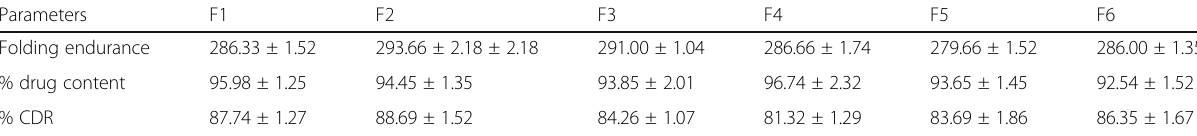
Table 6 Results of stability testing of piroxicam co-crystal buccal films at room temperature